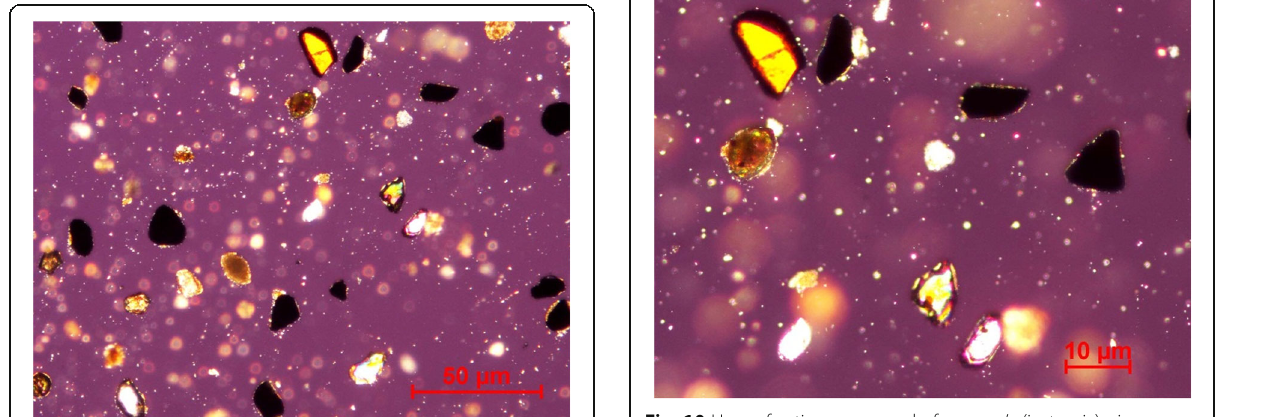
Fig. 10 Heavy fraction composed of opaque ’ s (isotropic), zircon (exhibits zoning and green, yellow, or violet interference colors), and staurolite (exhibits golden yellow interference colors at the upper left corner), Heavy fraction, C.N. ×